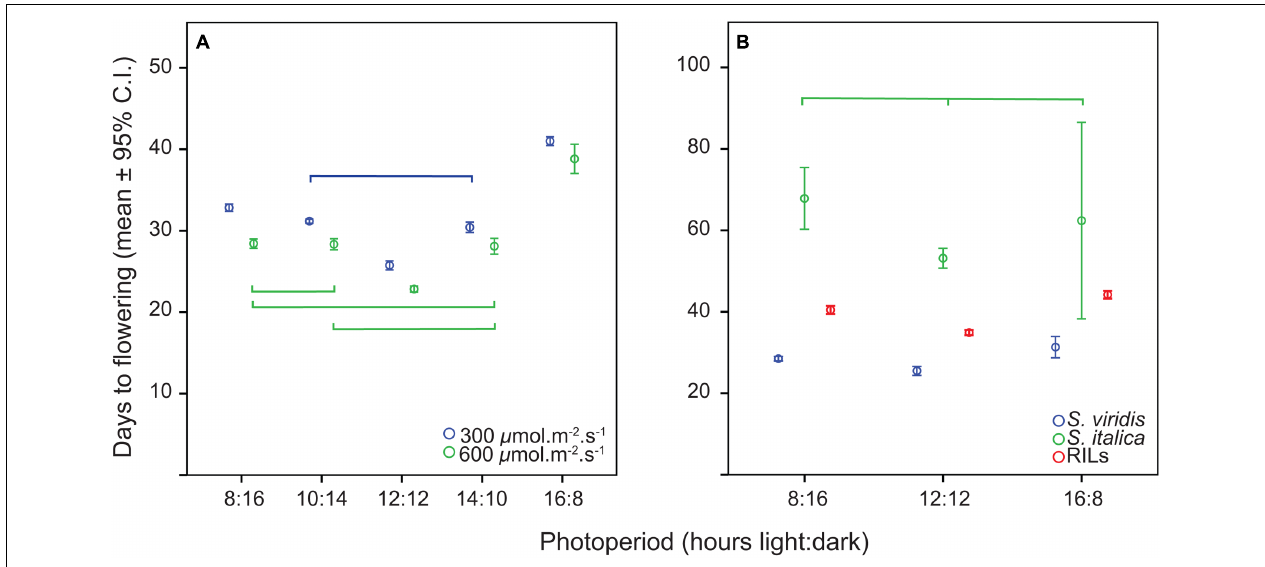
FIGURE 1 | Means and 95% confidence intervals for flowering time in the two trials. (A) S. viridis photoperiod trial, (B) S. viridis , S. italica, and RILs in QTL trials. Connecting brackets between points indicate which treatments were not significantly different for flowering time, and color indicates to which group the brackets